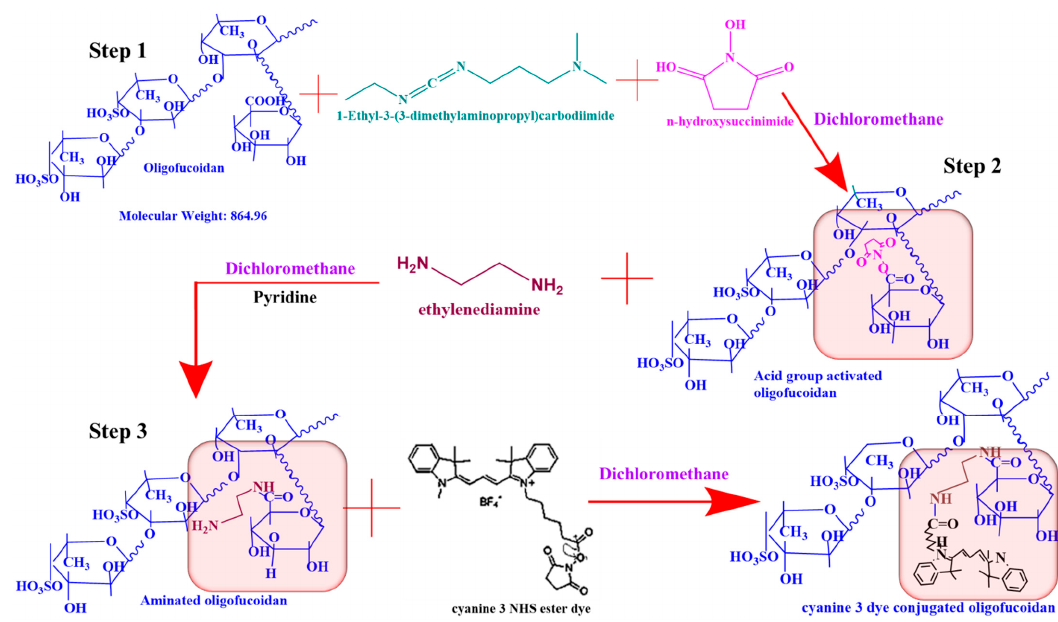
Figure 5. Schematic representation of the conjugation of Cy3 dye with Fucoidan (Fuc-Cy 3). 3.4. UV Spectral Confirmation of the Fuc-Cy3-L-Arg Fiber Complex Prior to cellular internalization, the Fuc-Cy3-L-Arg fiber complex absorbances and intensities were observed using UV and photoluminescent spectroscopy, respectively. The Cy3 dye was then conjugated to fucoidan to assess cellular uptake. The UV absorbances of the Fuc-Cy3-L-Arg complexes (1:1, 1:2.5, and 1:5) were measured and determined to be similar to that of Fuc-Cy3 at 512 and 543 nm(Figure 6) [24,38]. The fluorescence intensities of the Fuc-Cy3-L-Arg complexes are shown in the supplementary data (S4). Thereafter, the confirmed Fuc-Cy3-L-arg complexes were used for further biocompatibility and cellular internalization studies.